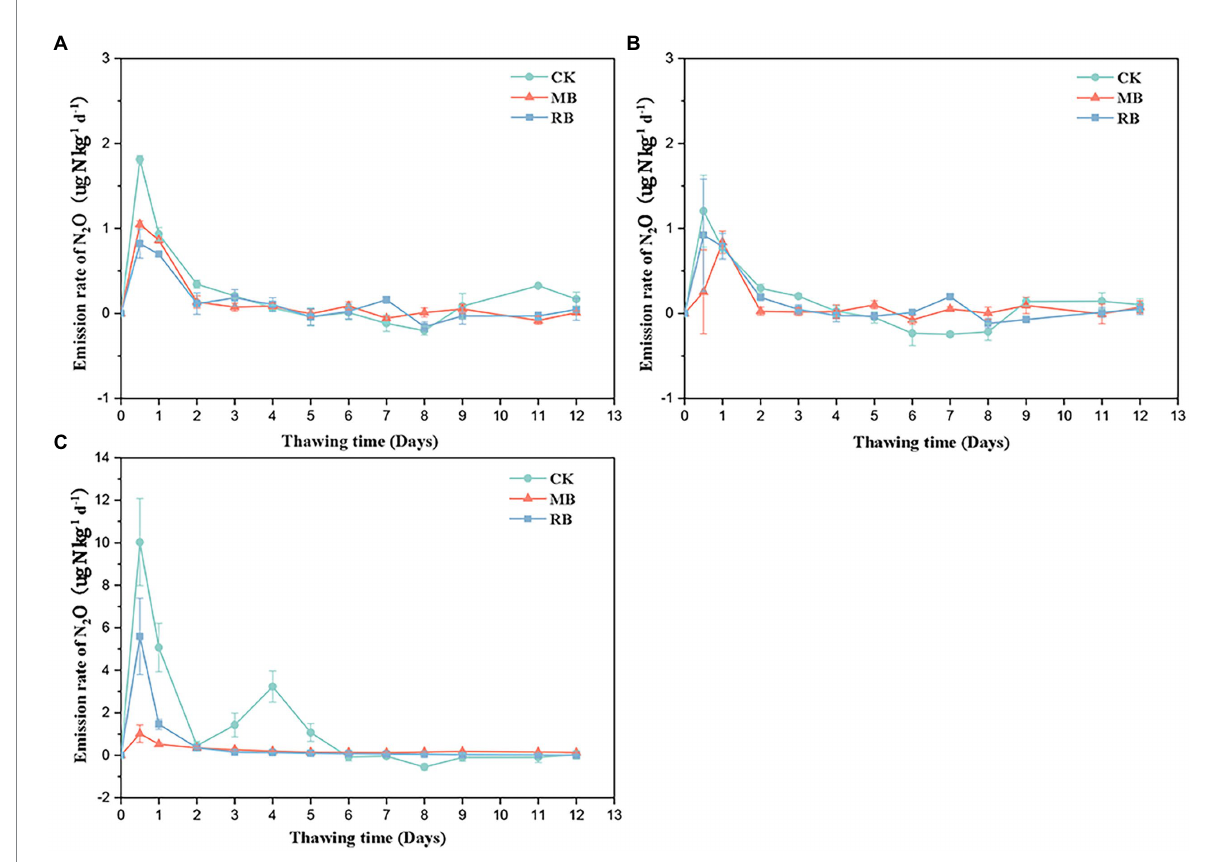
FIGURE 2 Emission rates of soil nitrous oxide (N 2 O) with biochar amendments during the thawing period under 60% water holding capacity (WHC; A ), 100% WHC (B) , and flooding (C) . (MB: maize straw biochar; RB: rice straw biochar; error bars represent the standard error, n =